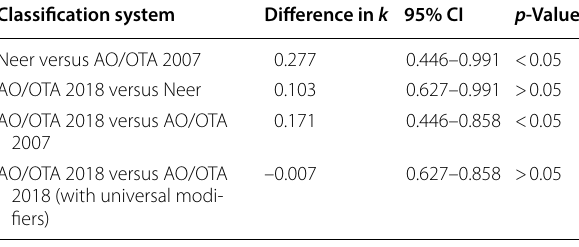
Table 7 Comparison of k coefficient values for intraobserver